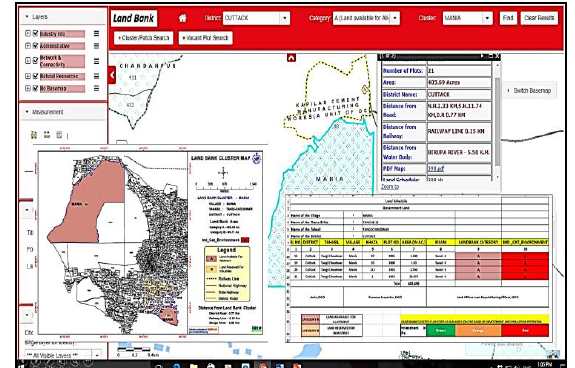
Figure 3. User Query Modules in GOPLUS